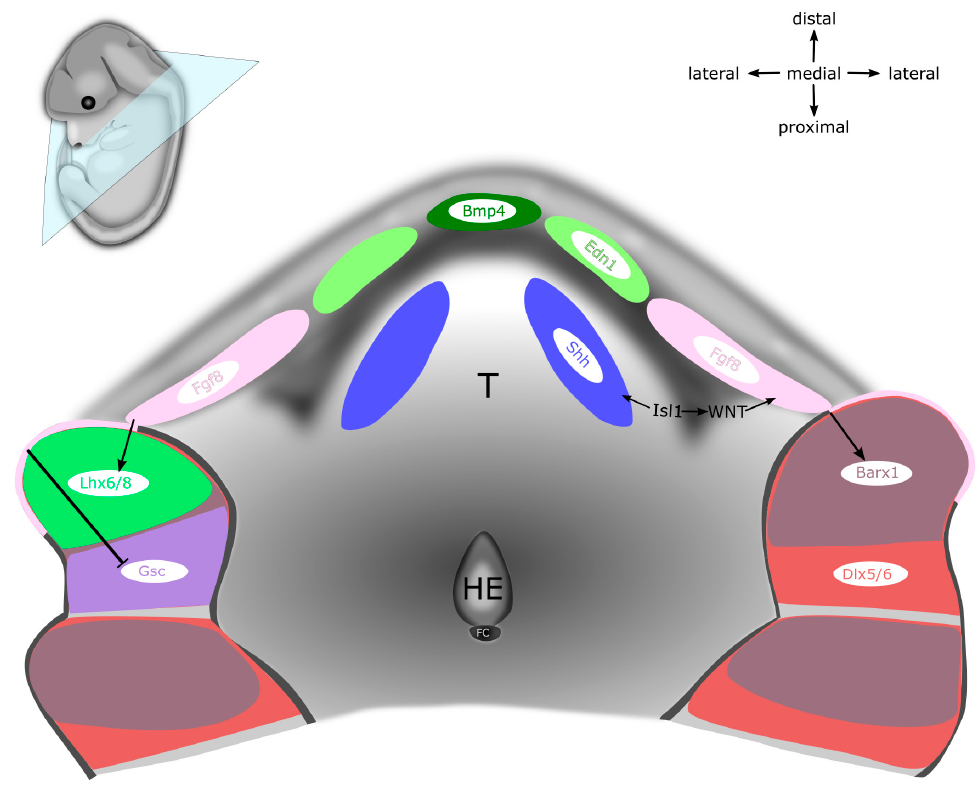
Figure 4. Schematics of the mandibular and hyoid regions of a mouse embryo at E12, superior view at the nascent tongue from inside of the alimentary canal. Bmp4 and Edn1 are expressed in the distal mandibular epithelium, while Bmp4 also marks the site of presumptive incisors. Shh is expressed in lingual epithelium of the tongue primordium. Fgf8 is expressed in the proximal mandibular epithelium, at the site of presumptive molars, while Barx1 is expressed in the proximal mandibular ectomesenchyme, surrounding the molar primordia, and in ectomesenchyme of the hyoid arch. Dlx5/Dlx6 are expressed in ectomesenchyme of the mandibular process and the hyoid arch. Lhx6/Lhx8 are expressed in the ectomesenchyme on the rostral side, while Gsc is expressed on the caudal side of the mandibular process. Abbreviations: E, embryonic day; T, tongue primordium; HE, hypobranchial eminence (second PA); FC, foramen caecum. Expression domains of genes written in black text are not highlighted in the figure.